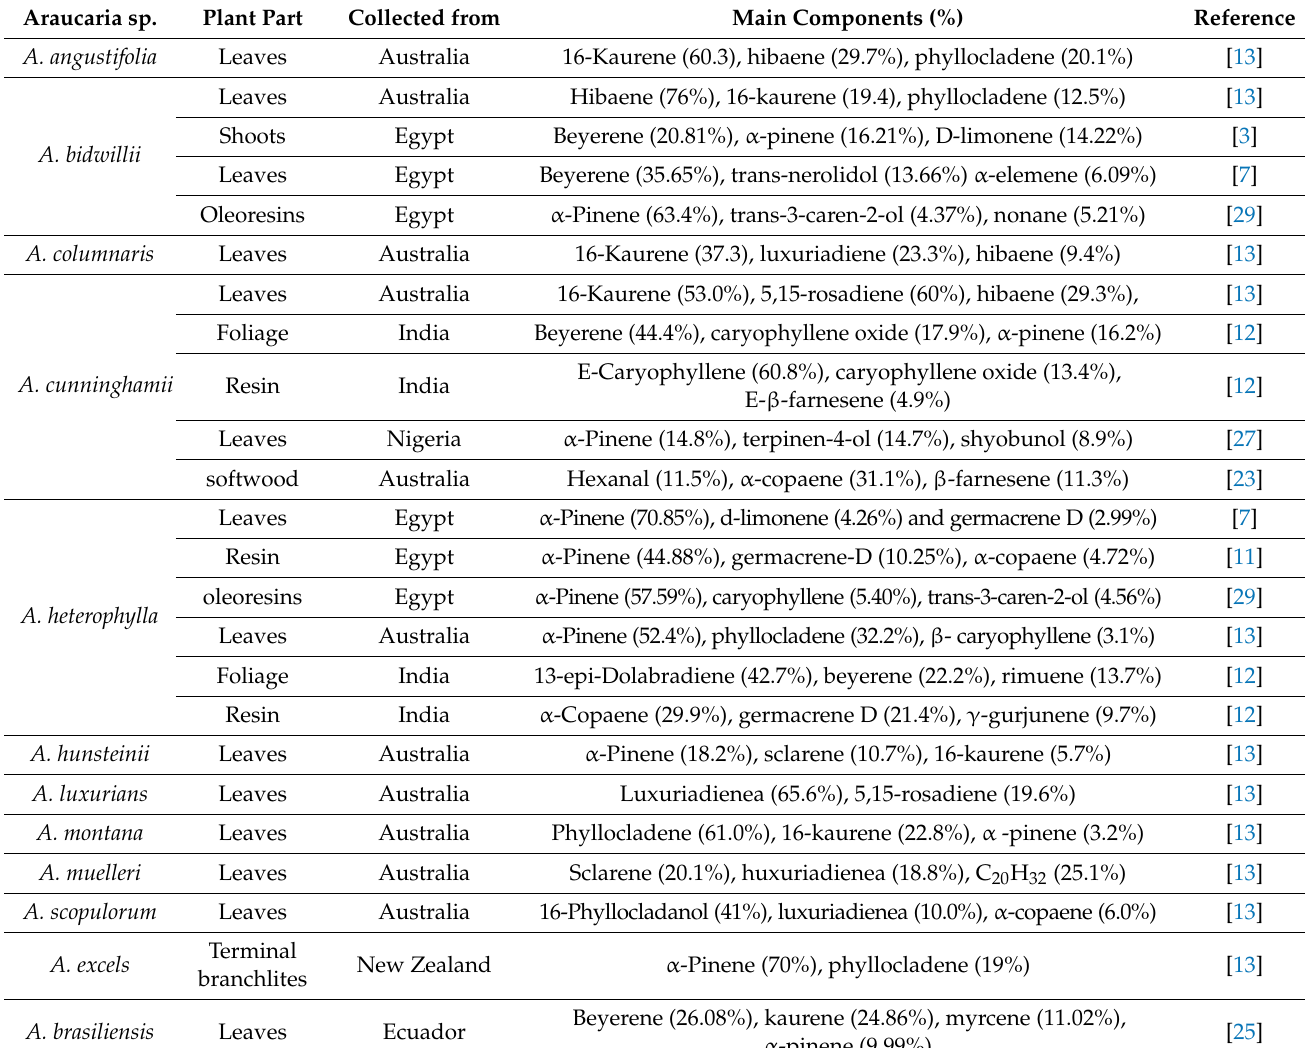
Table 3. Main components of EOs of some Araucaria plants.